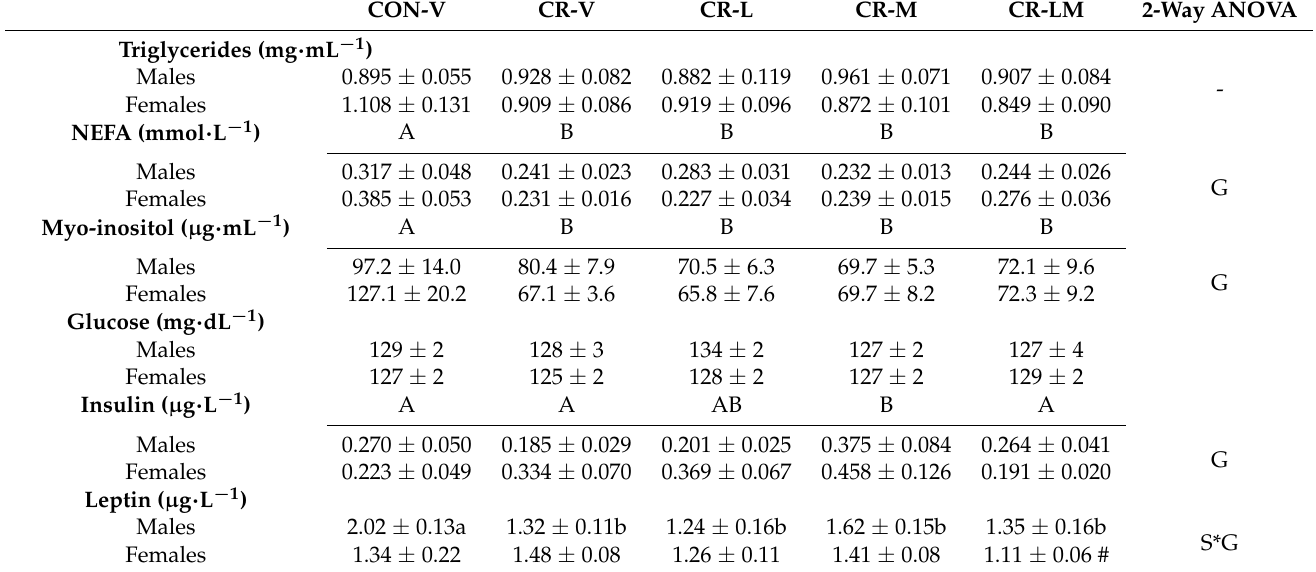
Table 2. Circulating triglyceride, NEFA, myo-inositol, glucose, insulin, and leptin levels of 25-day-old male and female offspring of control (CON) and 25% gestational calorie-restricted (CR) dams. Data are means ± s.e.m ( n = 9–10). Statistics: Two-way ANOVA was performed to assess the effects of sex and group (CON-V, CR-V, CR-L, CR-M, and CR-LM). One-way ANOVA was carried out to determine differences between groups in each sex separately when previous two-way ANOVA showed interactive effect between sex and group. ANOVA was followed by a least significant difference (LSD) post-hoc test. Mann–Whitney U test was used for single comparisons between groups. Symbols: G, effect of group; S*G, interactive effect between sex and group; A (cid:54) = B ( p < 0.05, two-way ANOVA); a (cid:54) = b ( p < 0.05, one-way ANOVA); #, different from their respective CR-V group ( p < 0.05, Mann–Whitney U test). Abbreviations: vehicle (V), leptin (L), myo-inositol (M), leptin